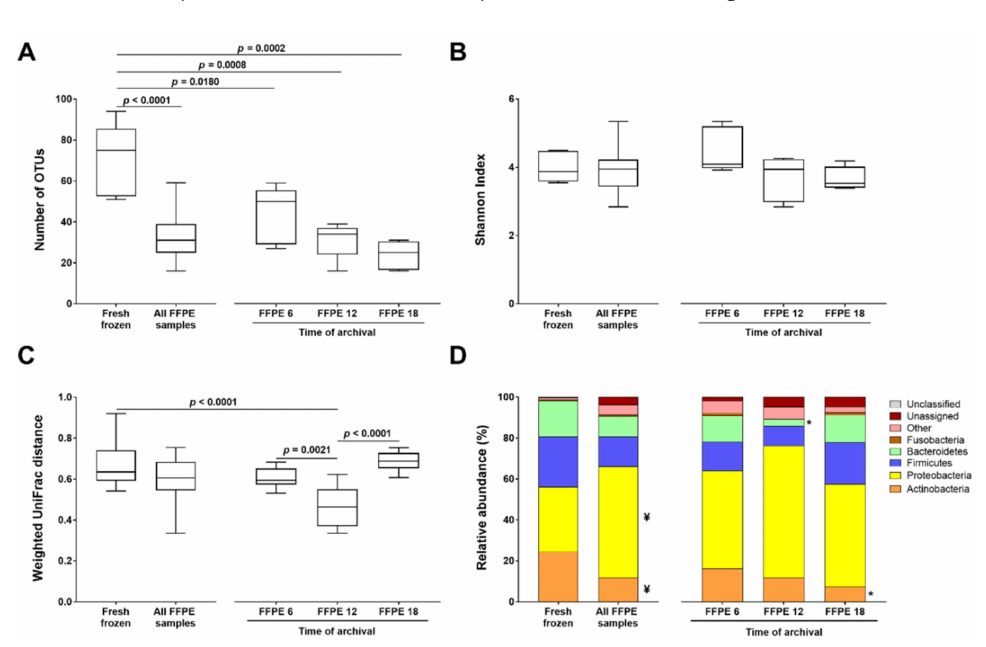
Figure 2. Comparison of the microbiota profiles between frozen and FFPE tissues and between di ff erent times of FFPE tissue archiving ( A ) Number of OTUs in each group of samples. ( B ) Microbial alpha-diversity assessed by the Shannon index. ( C ) Microbial beta-diversity calculated by the weighted UniFrac distances. ( D ) Relative abundance of phyla in frozen tissues, all FFPE tissue samples, and FFPE tissues archived for 6, 12, and 18 months. ¥ and * stand for significantly di ff erent from frozen tissues at p <